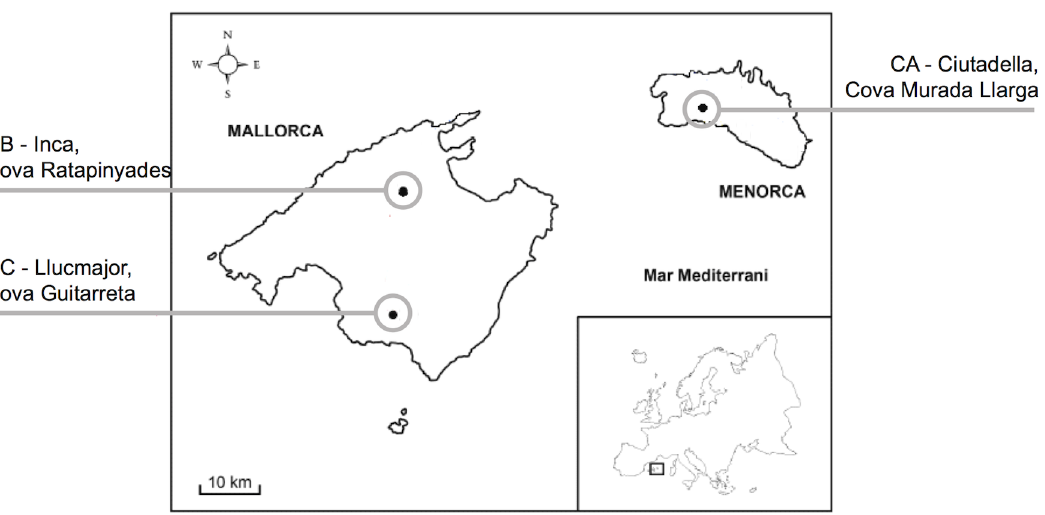
Figure 1. Map of Mallorca and Menorca. Map of Mallorca and Menorca (in the Balearic Islands) and the locations of the caves (CA, CB and CC) considered in the system studied.